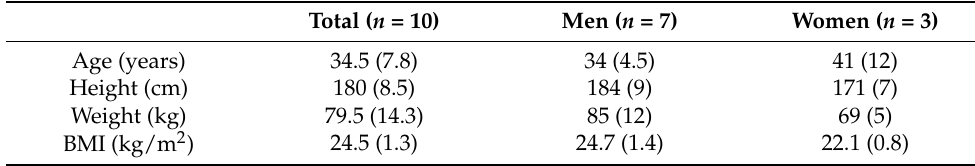
Table 1. Baseline characteristics of final